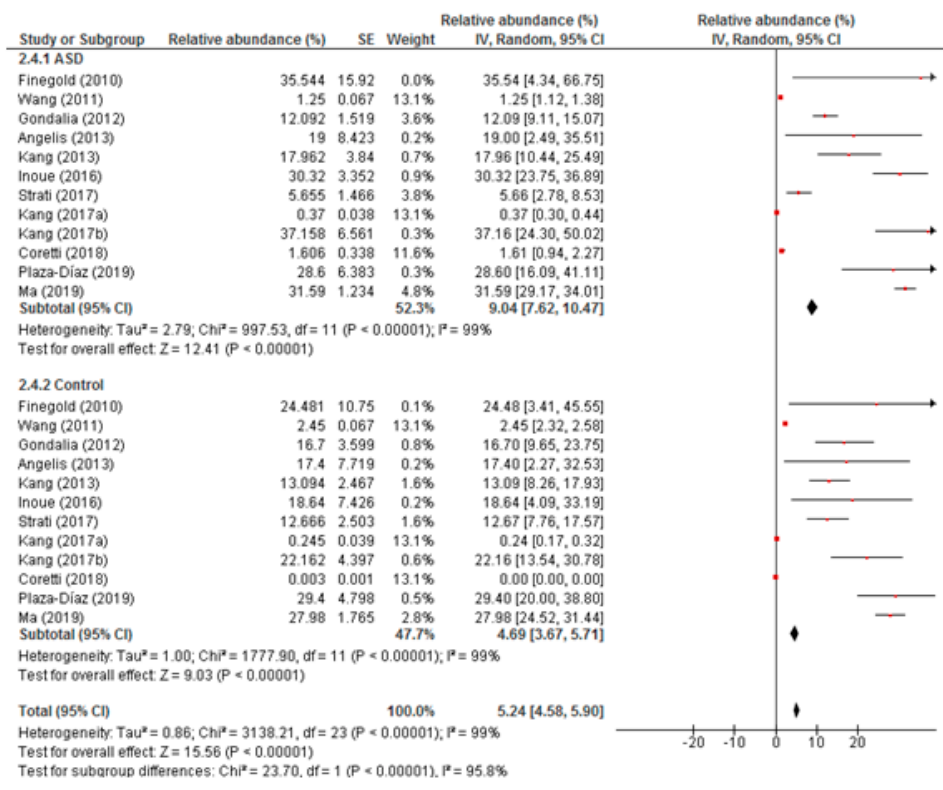
Figure 2. Forest plot of relative abundance of Bacteroides in children with ASD and controls.